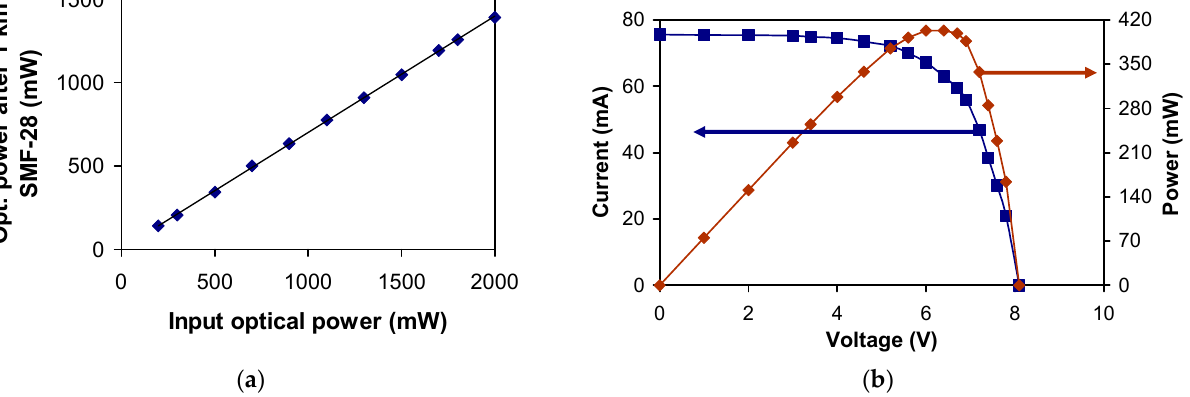
Figure 2. ( a ) 976 nm transmission efficiency through 1 km SMF-28 optical fiber. ( b ) I–V characteristic of the photovoltaic converter.